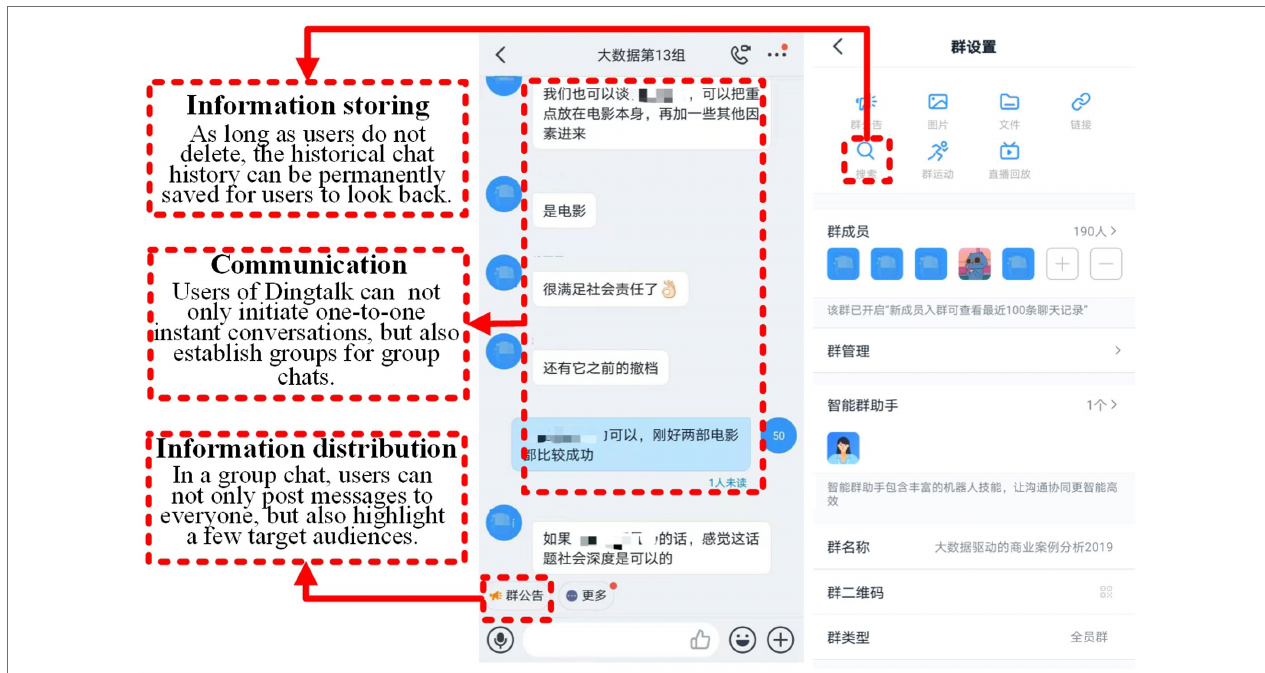
FIGURE 2 | An example of group chats in a mobile social